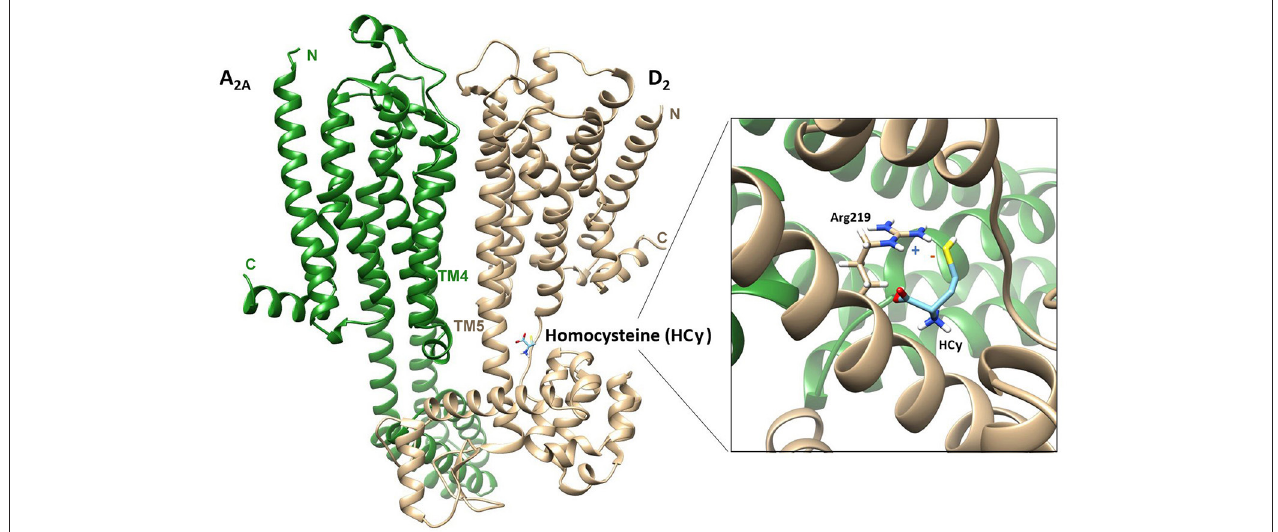
FIGURE 3 | Docking [obtained by means of the Rosetta software, (203)] of the crystallographically-assessed structures of adenosine A 2A [PDB code: 4EIY; (204)] and dopamine D 2 [PDB code: 6CM4; ( 205)] arranged to form the A 2A -D 2 heterodimer through a TM4-TM5 interface as recently described by (164). The docking of homocysteine (HCy) to the receptor complex is also shown. This occurs in an Arg-rich region [the epitope 115 VLRRRRKRVN] of the D 2 receptor ICL3 and is consistent with an electrostatic interaction between the negatively charged thiol group in HCy and the positively charged guanidinium group of arginine (